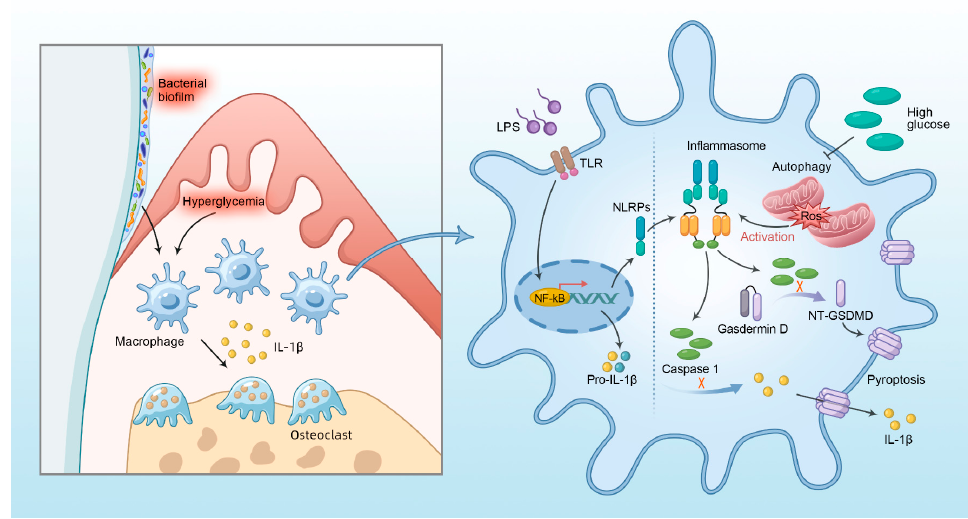
Figure 7. Diagram illustrates that hyperglycemia could promote macrophage pyroptosis via autophagy impairment and ROS ‐ inflammasome pathway and aggravate inflammatory diseases tophagy impairment and ROS-inflammasome pathway and aggravate inflammatory diseases such such as periodontitis. as